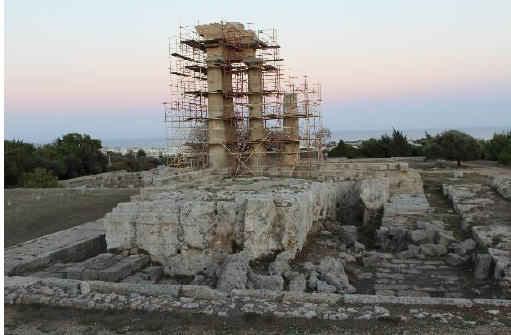
Figure 2: The Temple of Pythian Apollo under